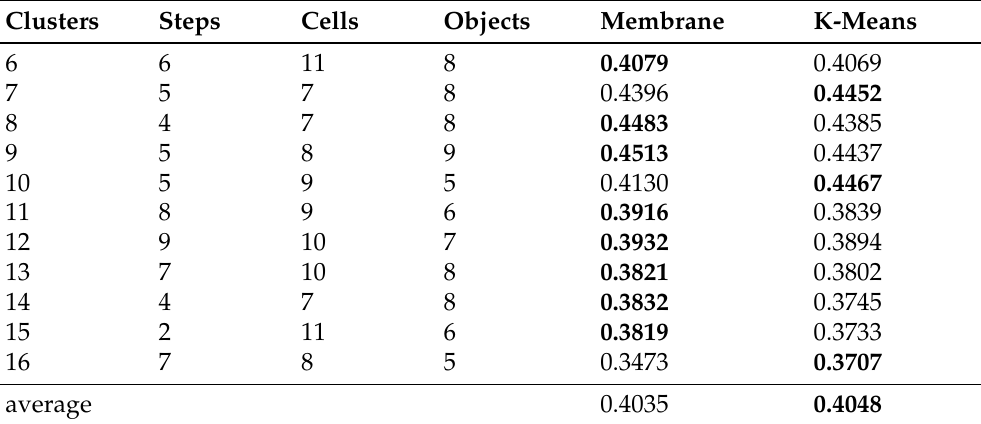
Table 9. Silhouette scores of the K-Means and the membrane clustering with the different number of clusters and m between 4 and 16 and using different membrane configurations. The Better scores are bold in the